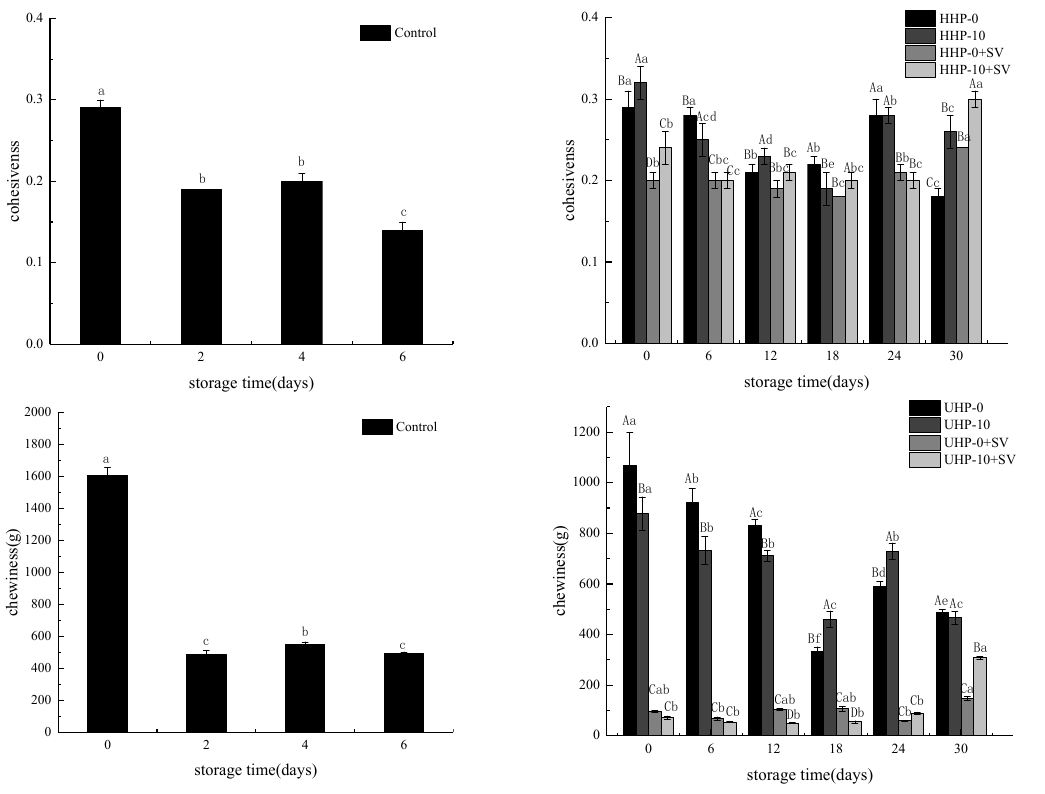
Figure 2. The effect of different treatments on sensory evaluations: springiness, hardness, cohesive- ness and chewiness of largemouth bass during storage. A–D: Differences between different treatment groups; a–f: Differences in treatment groups during storage.